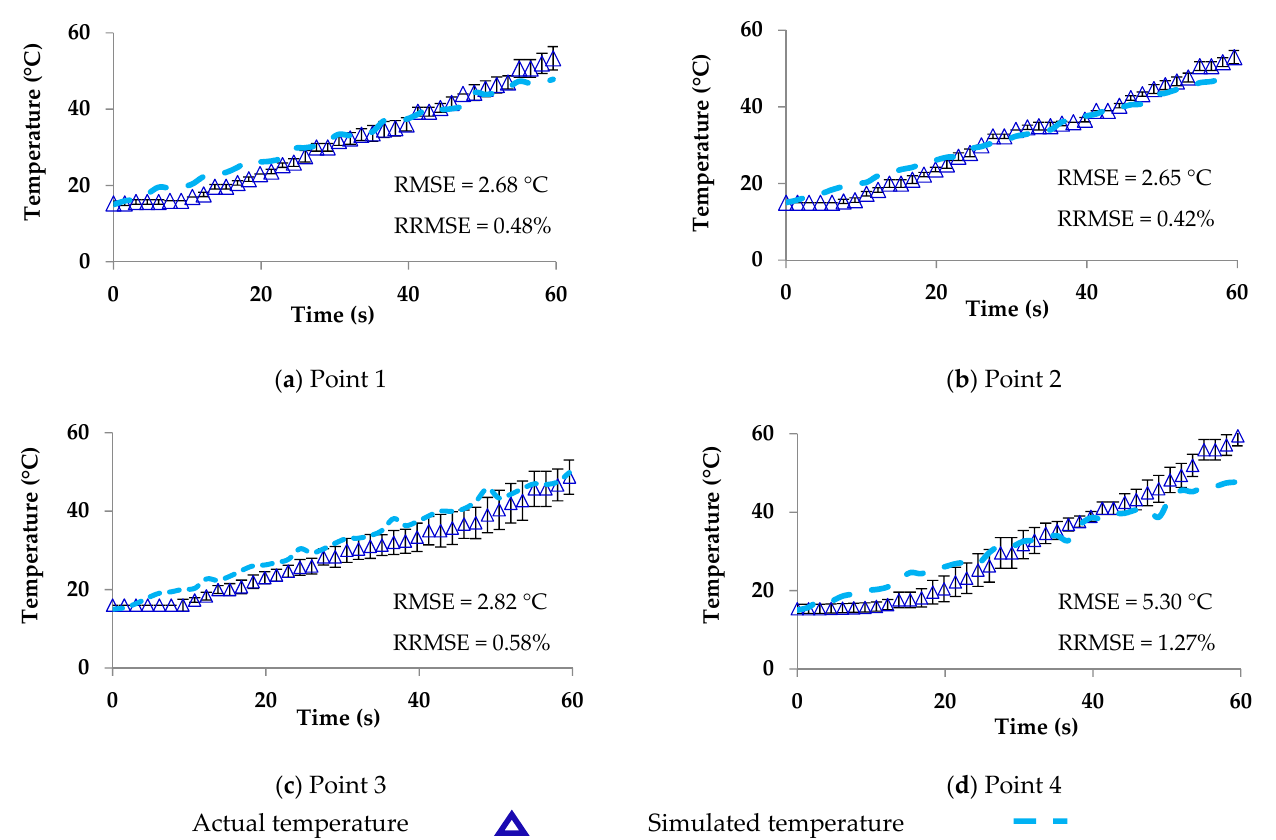
Figure 12. Actual and simulated temperature of ready-to-eat sausage under microwave rotating at points 1–4 from COMSOL in combination with MATLAB.